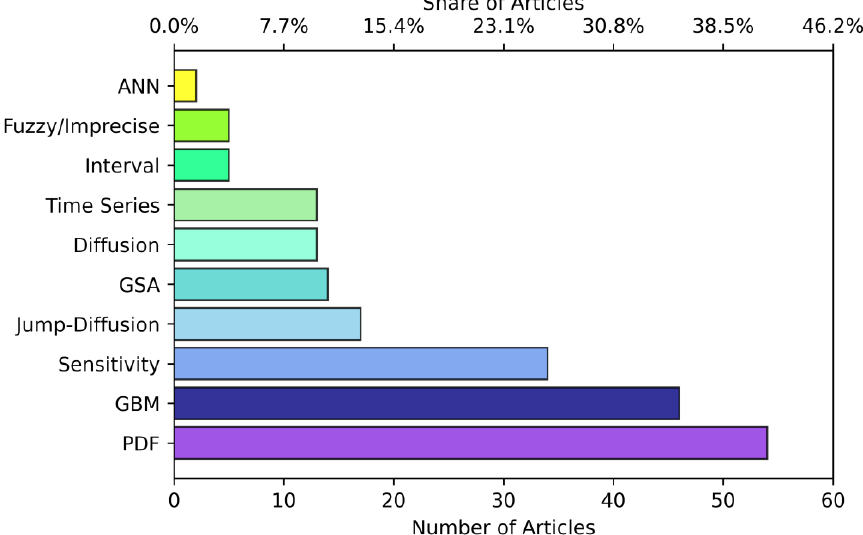
Figure 6. Number and share of articles in the pool that consider each UCM. Each article may consider more than one UCM.